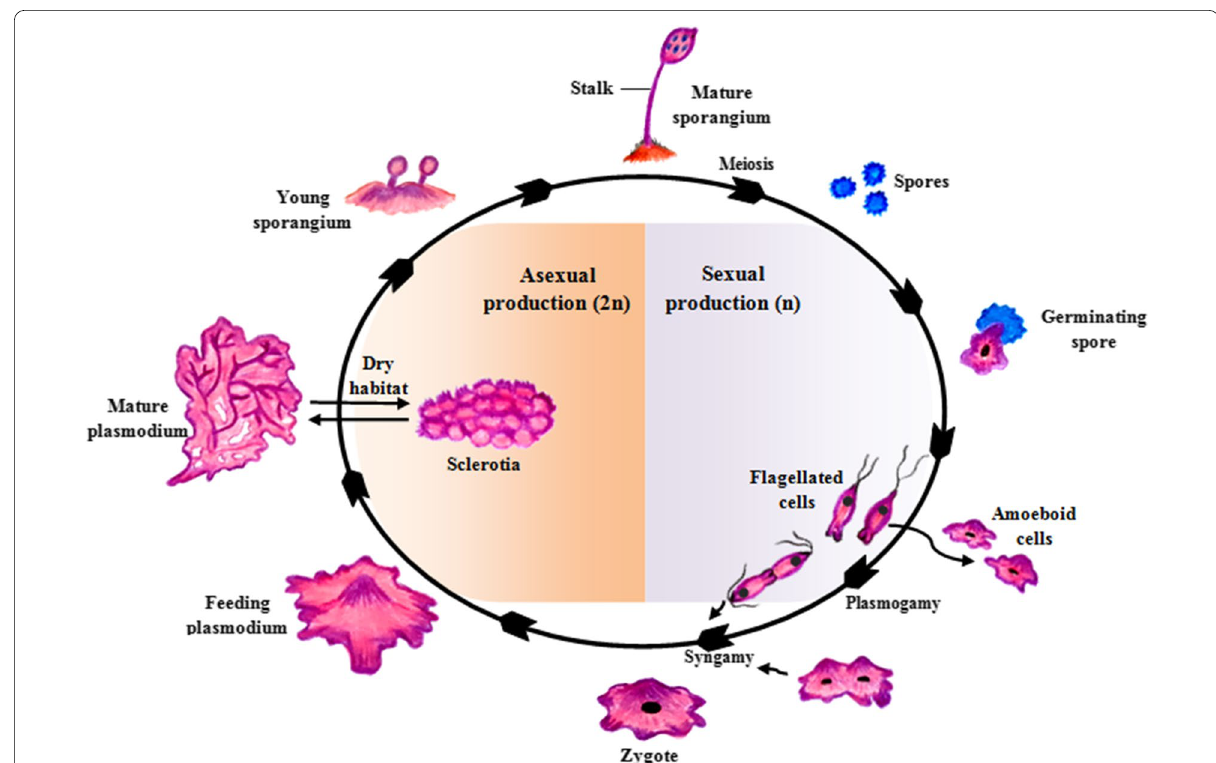
Fig. 1 The life cycle of a plasmodial slime mold includes sexual and asexual